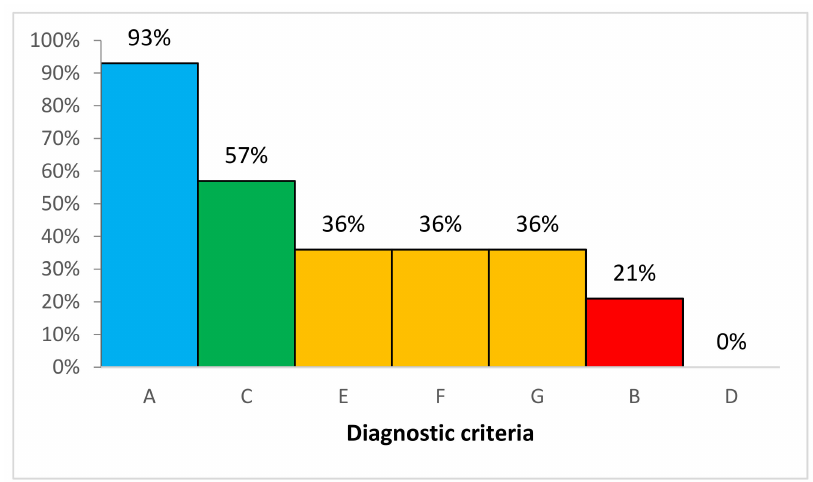
Figure 6. The fulfilment of diagnostic criteria based on the relevant indicator values in the analyzed territorial units. Source: own